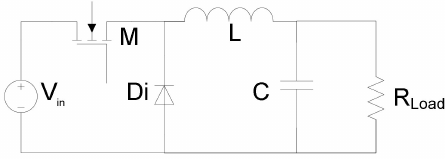
Figure 1. Buck converter circuit.